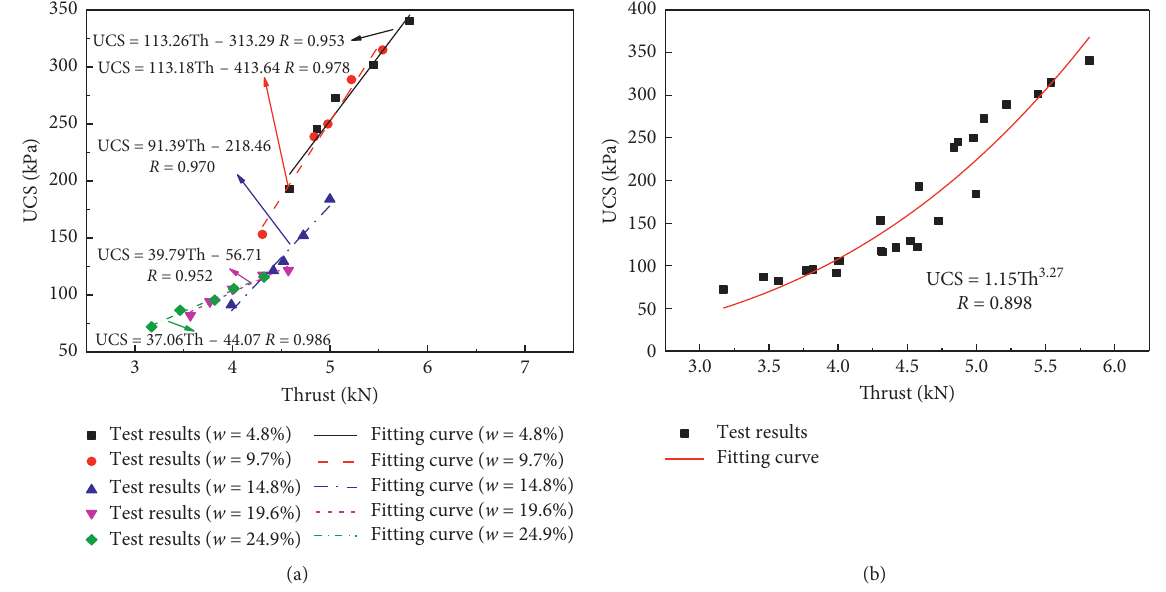
Figure 9: Relationship between propulsion and UCS: (a) considering water content and (b) without considering water content.